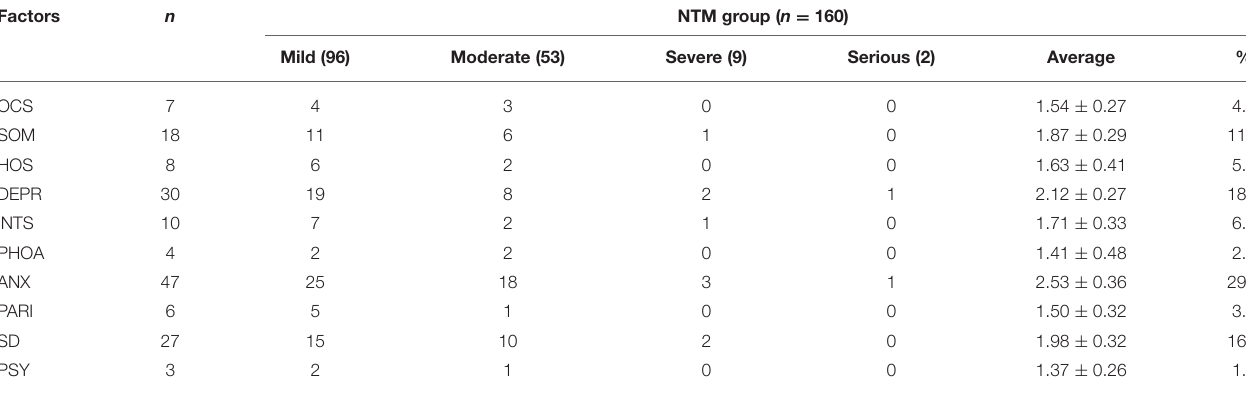
TABLE 4 | The symptom checklist-90 (SCL-90) assessment of the mental health of patients with NTM lung disease. Factors